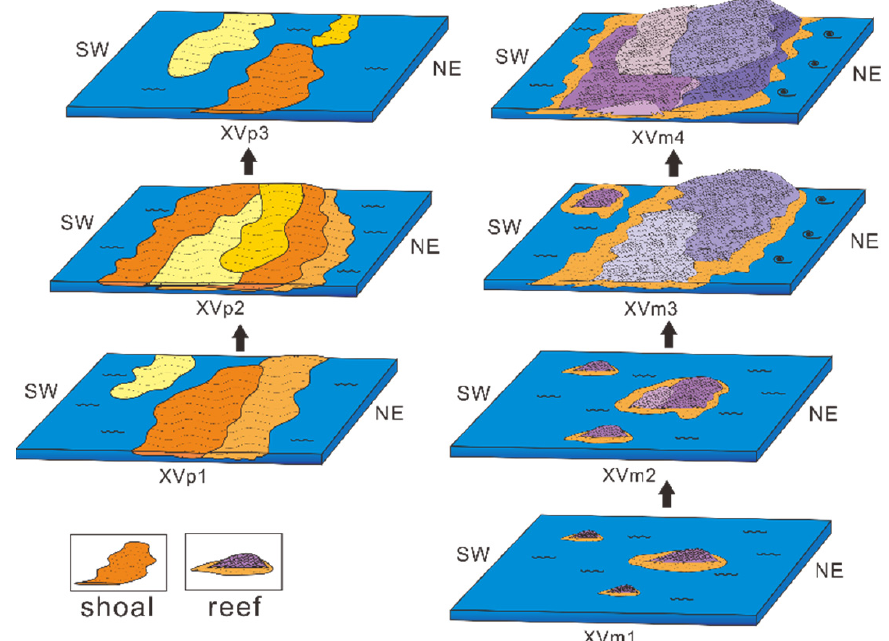
Figure 7. Reef shoal body sedimentary evolution model on XVm and XVp.